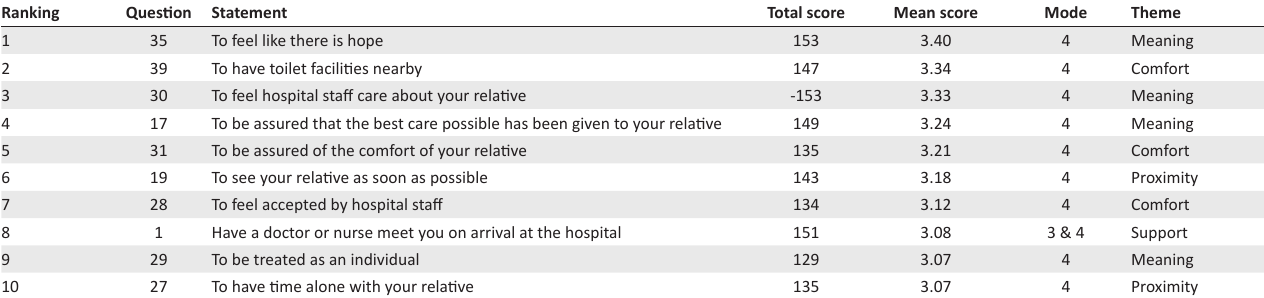
TABLE 3: Top 10 ranked needs statements CCFNI-2 (level of satisfaction).